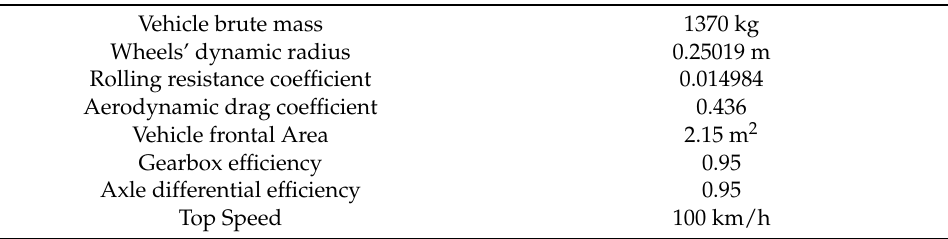
Table 3. Test vehicle physical and performance